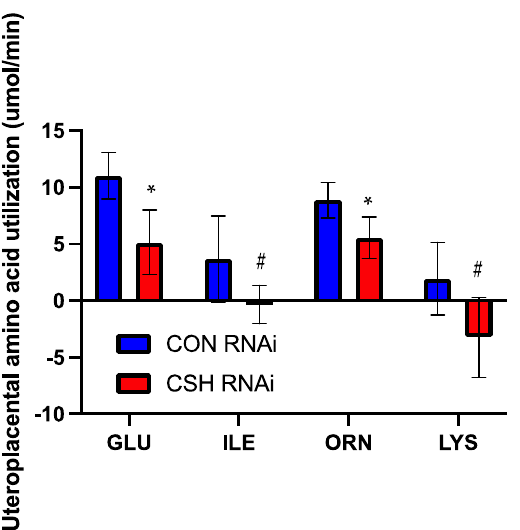
Figure 7. Uteroplacental utilization (µmol/min) of amino acids as assessed by 3 H 2 0 transplacental diffusion at 130 dGA. Data are shown as means ± SEM for all pregnancies in each treatment group. CSH, chorionic somatomammotropin; RNAi, RNA interference. Glu, glutamate; Ile, isoleucine; Lys, lysine; and Orn, ornithine. * p ≤ 0.05, # p ≤ 0.10, when CSH RNAi pregnancies are compared with control RNAi pregnancies.